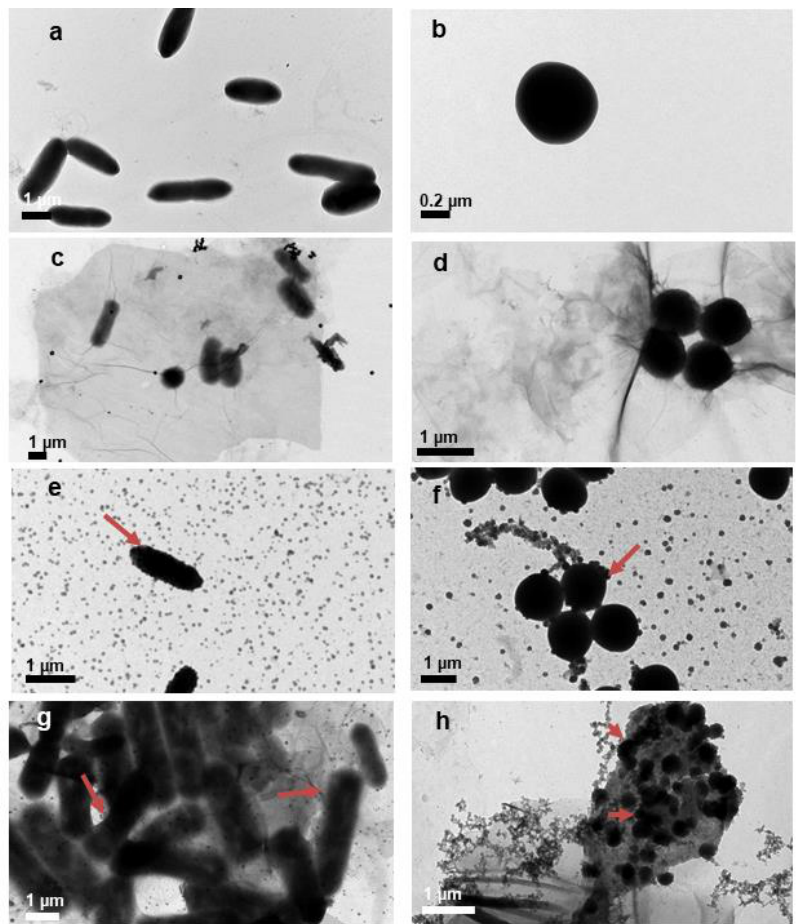
Figure 7. TEM images of pristine E. coli ( a ) and S. Aureus ( b ), those exposed to GO ( c , d ), to Ag NPs ( e , f ), and to GO-Ag NPs ( g , h ), respectively. Red arrows indicate the penetration of Ag NPs into the bacterial cell.